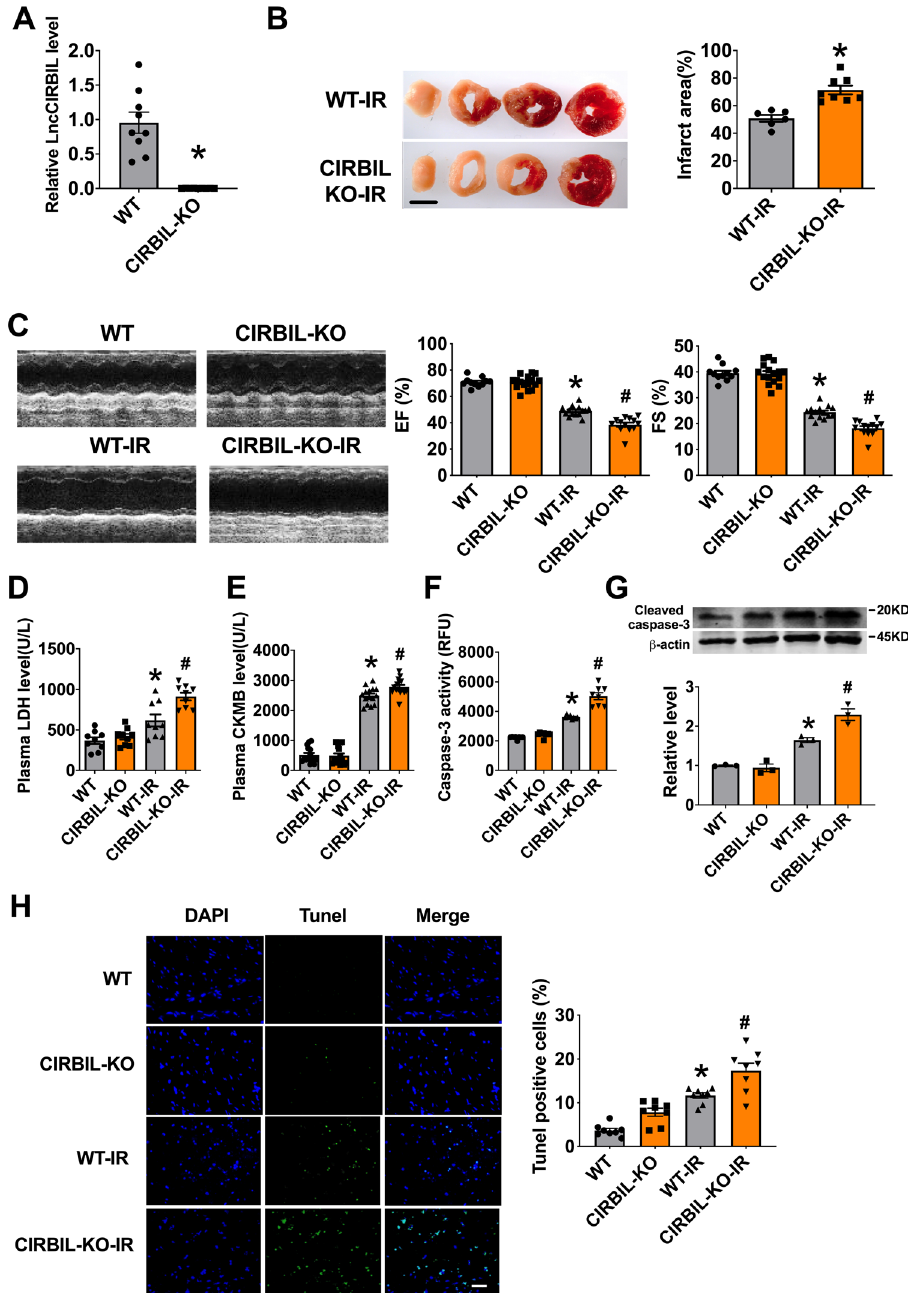
Fig. 2 Knockout of lncCIRBIL exacerbates cardiac ischemia – reperfusion injury. A LncCIRBIL levels in the hearts of lncCIRBIL knockout and wild-type (WT) mice. N = 9. * P < 0.05 versus WT group. P values were determined by unpaired t test. B Infarct size of I/R hearts stained with TTC (scale bar: 2 mm). WT-I/R N = 6, CIRBIL-KO-I/R N = 8. * P < 0.05 versus WT-IR mice. P values were determined by unpaired t test. C Representative images of echocardiographs and statistics of ejection fraction (EF) and fractional shortening (FS). WT N = 11, CIRBIL-KO N = 16, WT-I/R N = 14, CIRBIL-KO-I/R N = 13. * P < 0.05 versus WT; # P < 0.05 versus WT-IR mice. P values were determined by one-way ANOVA test followed by Bonferroni post hoc analysis. D Serum concentrations of LDH, respectively. N = 9 mice per group. * P < 0.05 versus WT; # P < 0.05 versus WT-IR mice. P values were determined by one- way ANOVA test followed by Bonferroni post hoc analysis. E Serum concentrations of CKMB, respectively. N = 15 mice per group. * P < 0.05 versus WT; # P < 0.05 versus WT-IR mice. P values were determined by one-way ANOVA test followed by Bonferroni post hoc analysis. F Caspase-3 activity. N = 8 mice per group. * P < 0.05 versus WT-IR mice. P values were determined by one-way ANOVA test followed by Bonferroni post hoc analysis. G Cleaved caspase-3 protein level. N = 3 mice per group. * P < 0.05 versus WT-IR mice. P values were determined by one-way ANOVA test followed by Bonferroni post hoc analysis. H Apoptosis of cardiomyocyte in the border zone (BZ) by TUNEL staining (scale bar: 20 μ m). N = 8 mice per group. * P < 0.05 versus WT; # P < 0.05 versus WT-IR mice. P values were determined by one-way ANOVA test followed by Bonferroni post hoc analysis. Data are expressed as mean ± SEM. CIRBIL-KO CIRBIL knockout mice, CIRBIL-KO-IR CIRBIL knockout mice with ischemia –